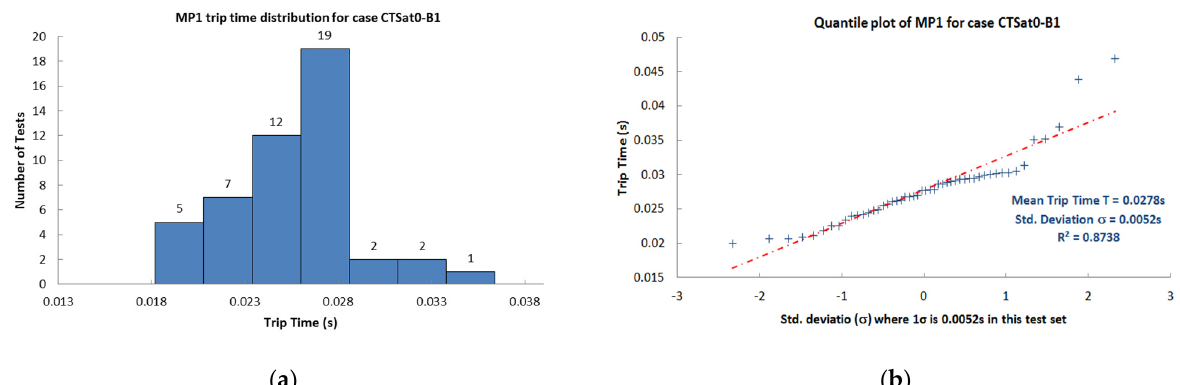
Figure 11. MP1 trip time distributions and quantile plot for case CTSat0-B1 (ideal CT, 1 faulty fibre, 3Ph-G fault at 50% of the feeder).